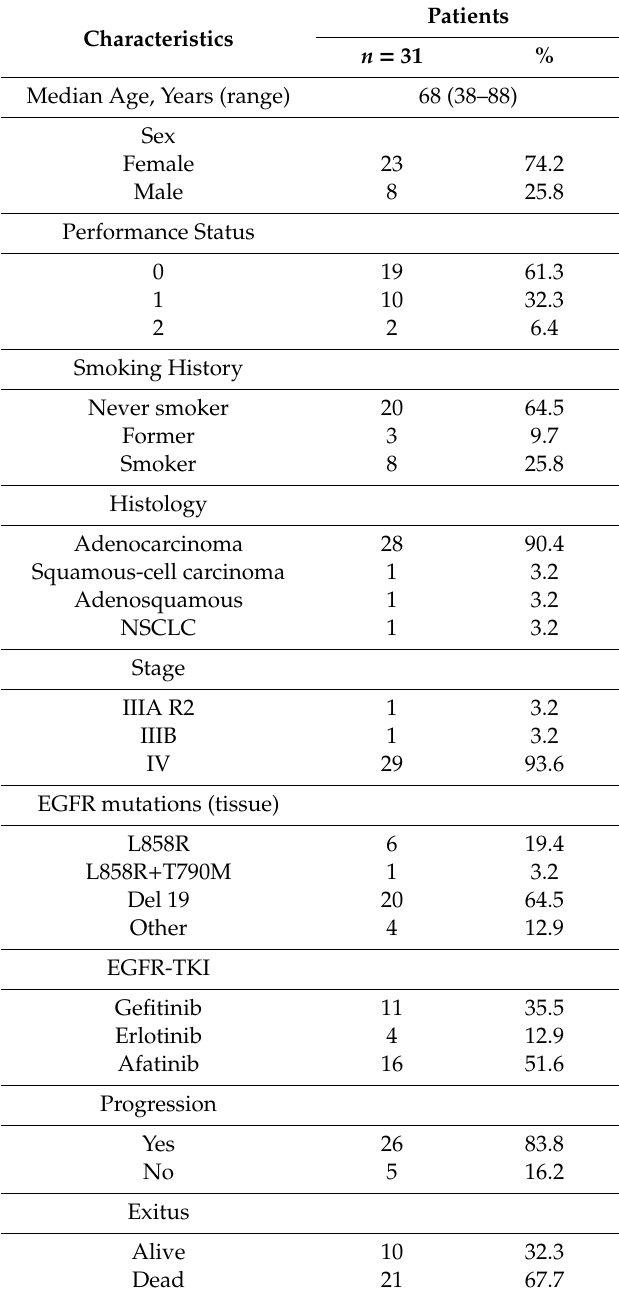
Table 1. Patient